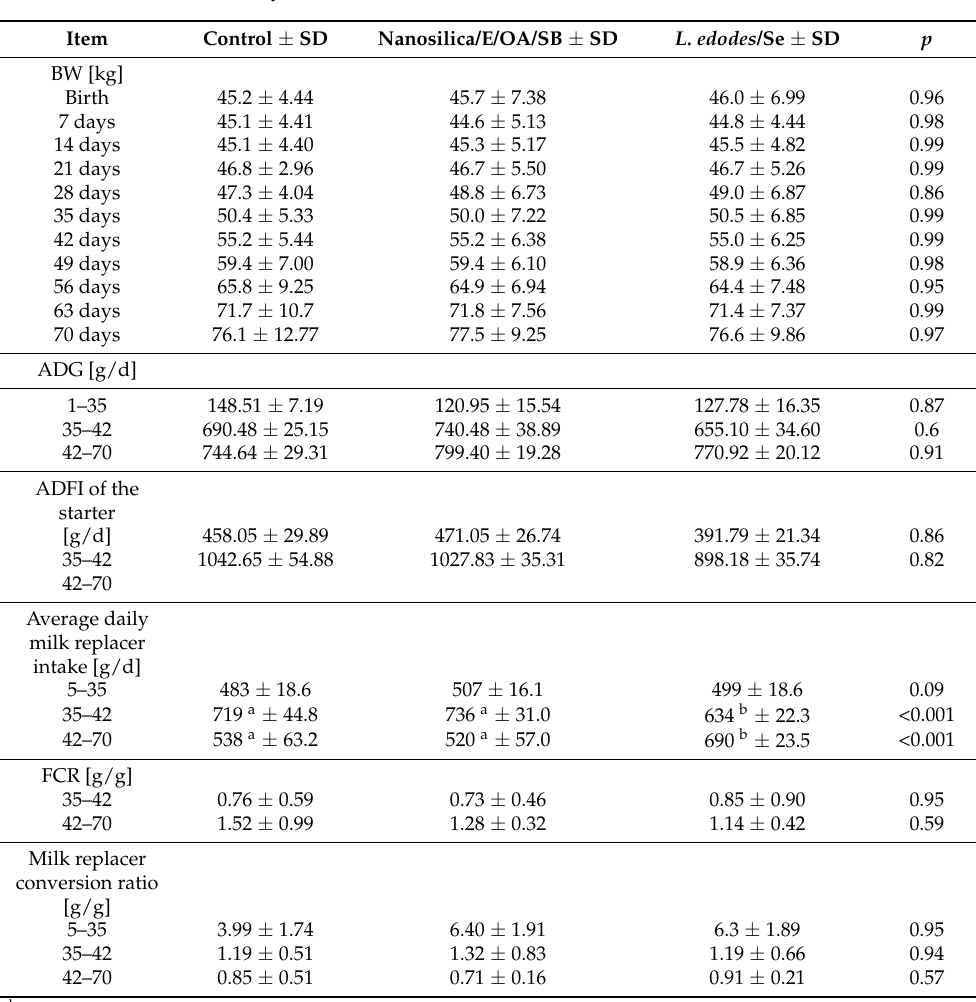
Table 4. Effect of dietary supplementation with nanosilica and L. edodes mycelium on calves’ perfor- mance between 4 and 70 days ( n =